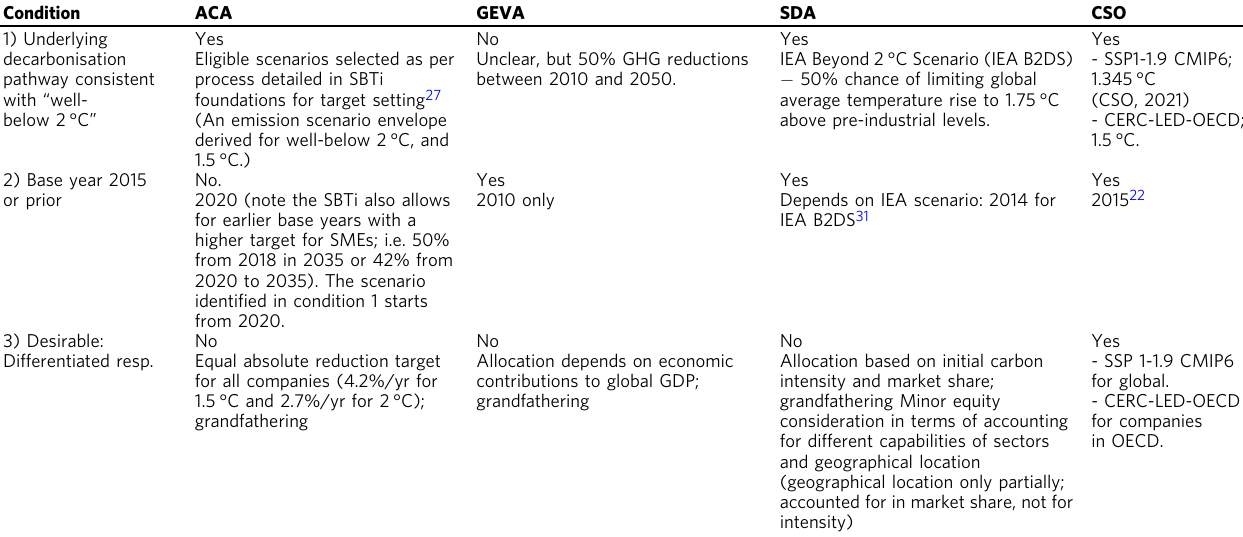
Table 1 The application of our three conditions of Paris Compliance to four allocation methodologies: the Sectoral Decarbonisation Approach (SDA), Greenhouse gas Emissions per Unit of Value Added (GEVA), the Absolute Contraction Approach (ACA) and the Context-based Carbon Metric method developed by the Centre for Sustainable Organisations (CSO).